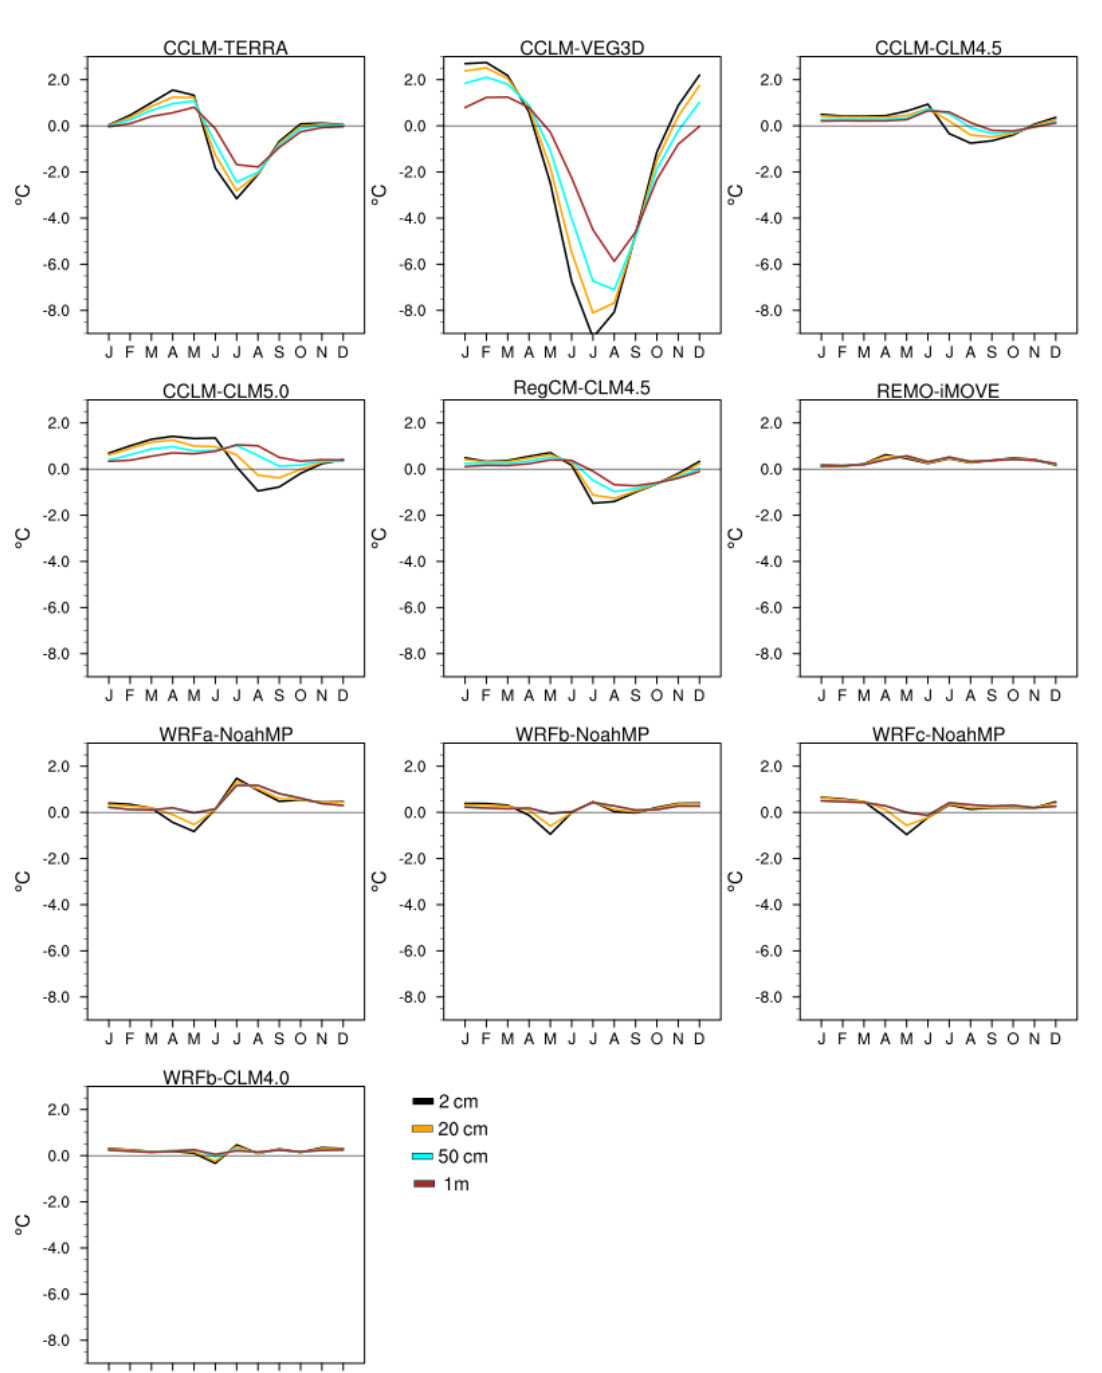
evaporation rates (Davin et al., 2020). Cloud fraction is also increased with afforestation in other CCLM configurations; however, the reduced incoming shortwave radiation is